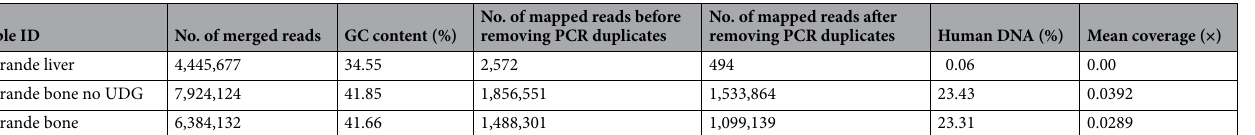
No. of merged reads GC content (%)